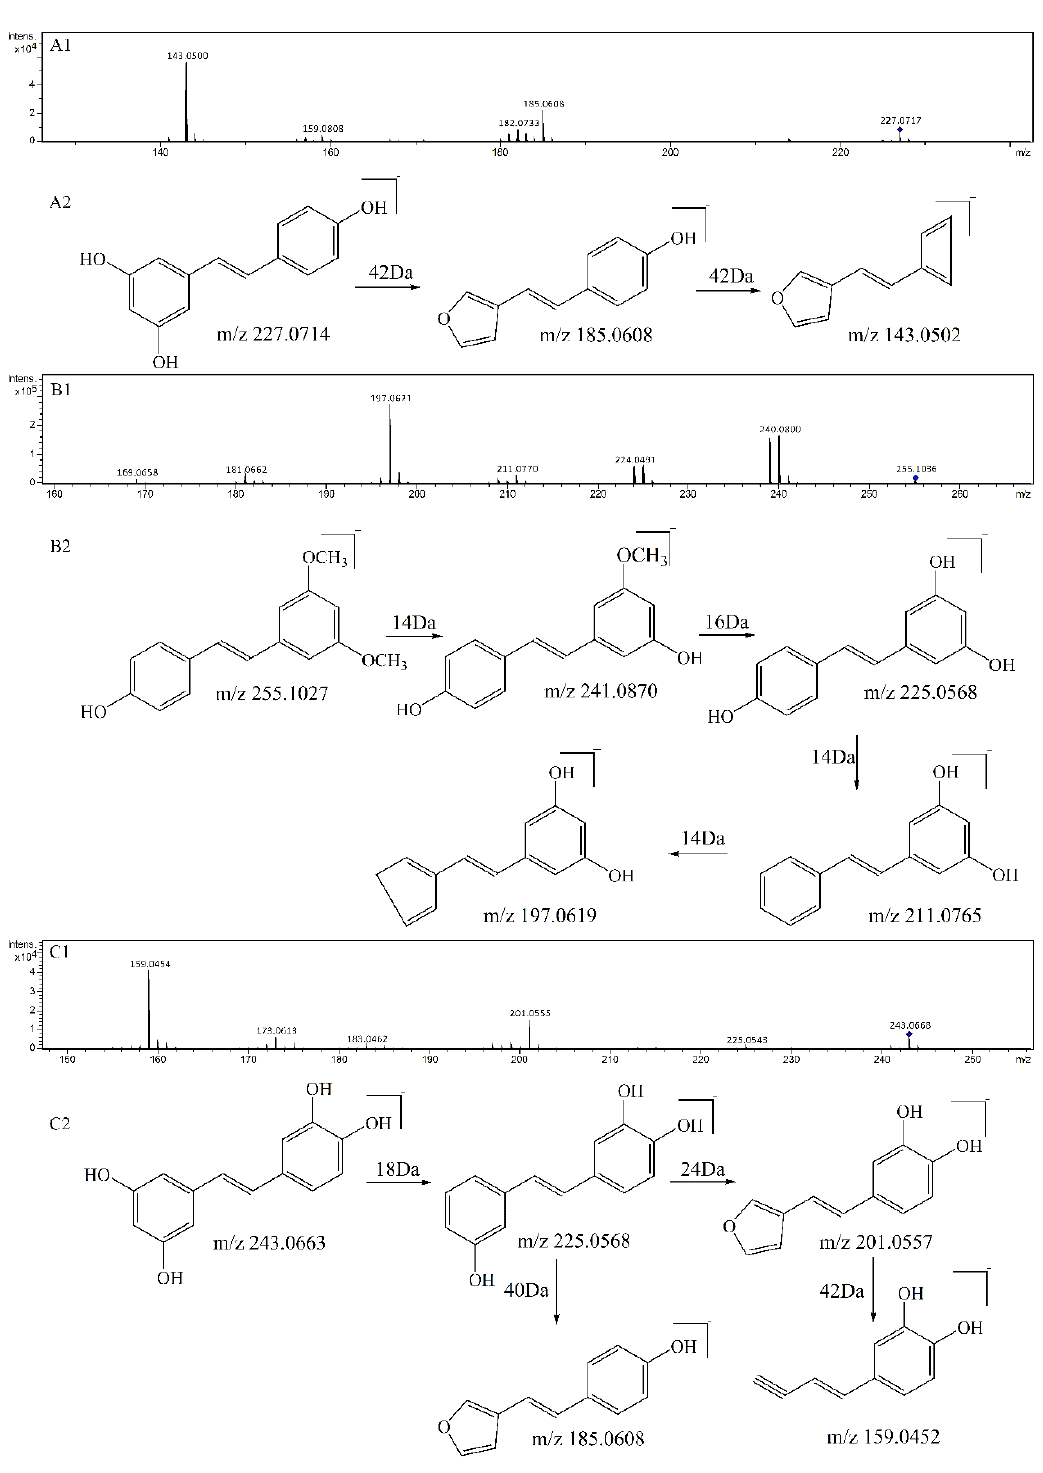
Figure 2. MS 2 spectrum of the precursor ion at m / z 227 ( A1 ) and its proposed fragmentation pathway ( A2 ). MS 2 spectrum of the precursor ion at m / z 255 ( B1 ) and its proposed fragmentation pathway ( B2 ). MS 2 spectrum of the precursor ion at m / z 243 ( C1 ) and its proposed fragmentation pathway ( C2 ).